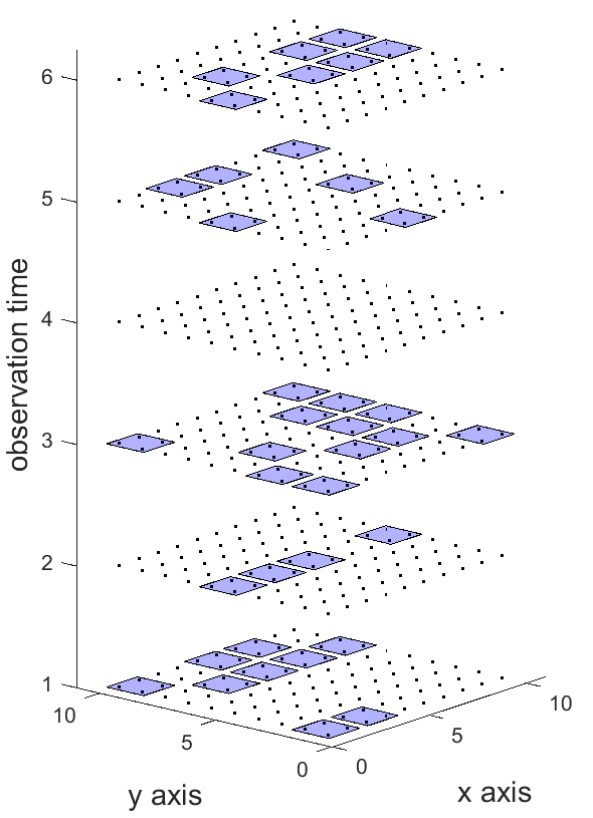
Figure 9. An example scheme of spatiotemporal sampling design. Blue grids represent the areas to be sampled, and the points in one grid measured by one single